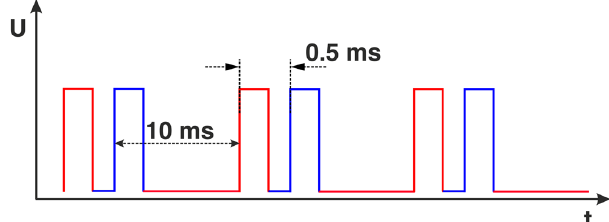
FIG. 3. Schematic of the burst mode, where pauses between odd- and even-numbered pulses (red and blue, respectively) are different. Note that the x axis is not linear, as the 1 μ s pulse width has been exaggerated for